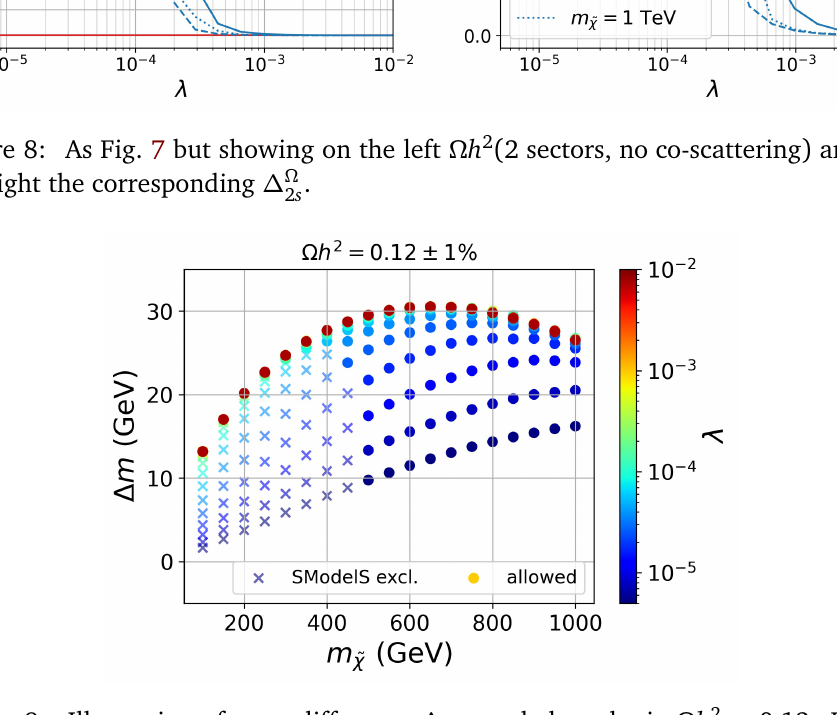
Figure 9: Illustration of mass difference ∆ m needed to obtain Ω h 2 = 0.12. Points marked as crosses are excluded by SM ODEL S